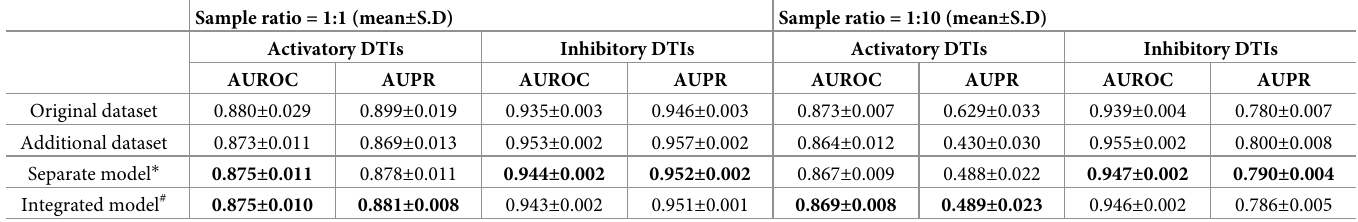
Boldface indicates the highest value for each performance metric between the separate model and integrative model. * Models trained on the original and additional datasets separately. # Models trained on an integrated